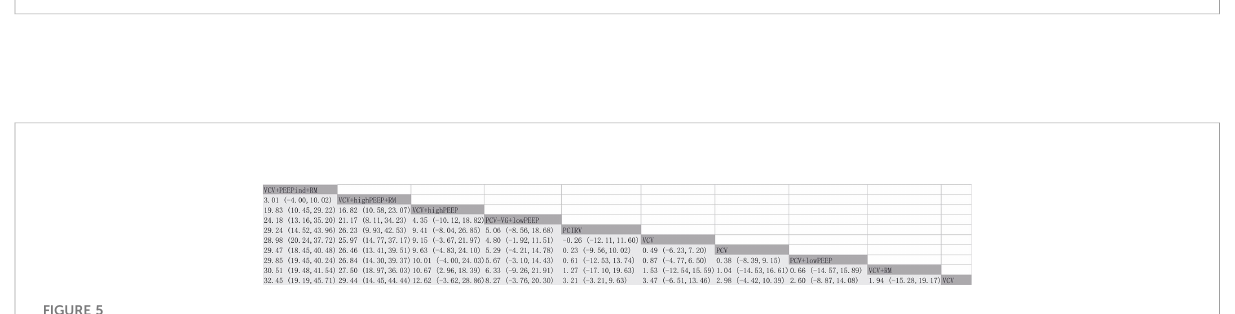
FIGURE 5 League table of pulmonary compliance under different ventilation strategies.